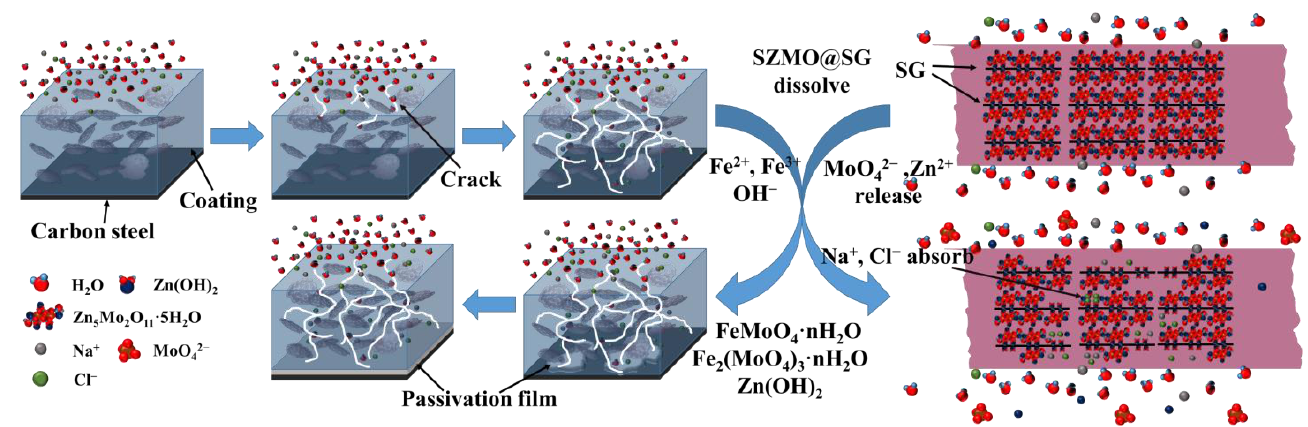
Figure 14. Mechanism diagram of corrosion resistance of coatings with SZMO@SG.